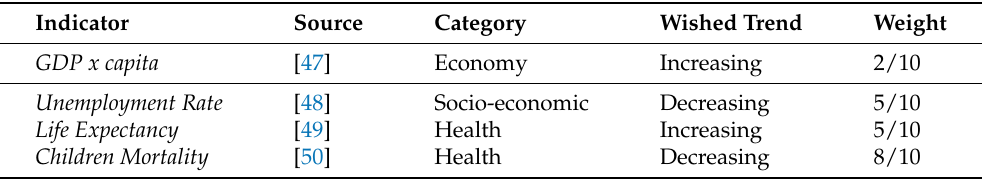
Table 2. Raw data and parametrization (Case Study